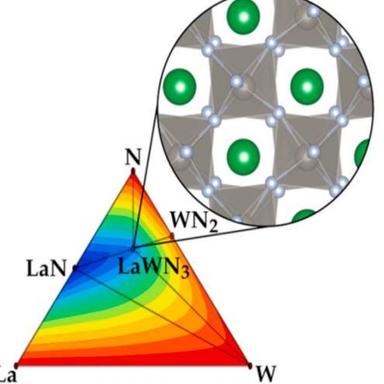
Theoretical ternary phase diagram for LaWN3 with perovskite-type structure after R.S. Perez et al. .